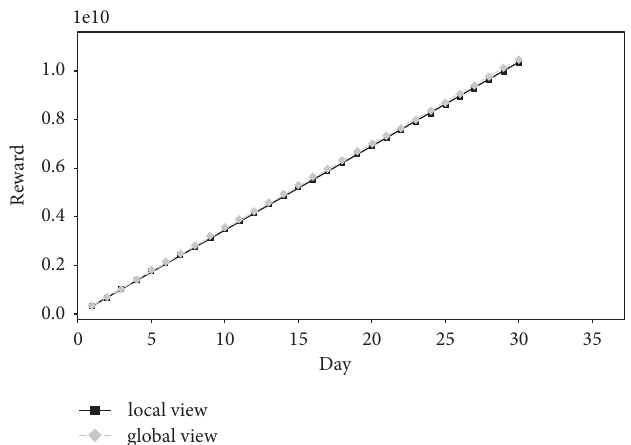
Figure 7: Total revenue comparison of two multiaction dispatching optimization models.